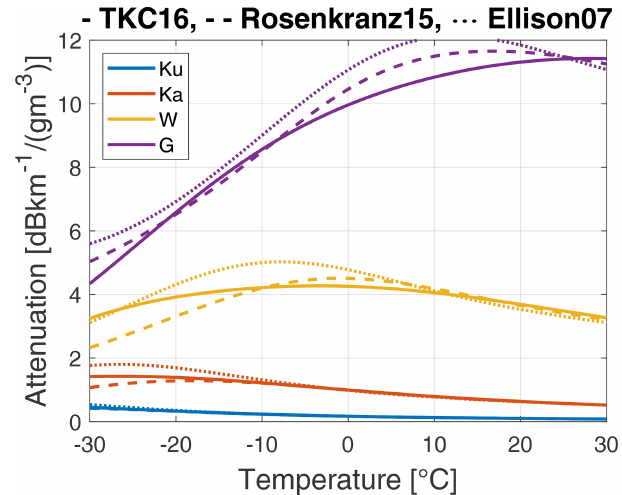
Figure 1. Attenuation coefficient of 10µm radius droplets (Rayleigh regime) as function of temperature for the K u (13.6GHz), K a (35 GHz), W (94GHz), and G (220GHz) bands . The different line types show the discrepancies between three recent models for computing the liquid water refractive index (Turner et al., 2016; Rosenkranz, 2015; Ellison,